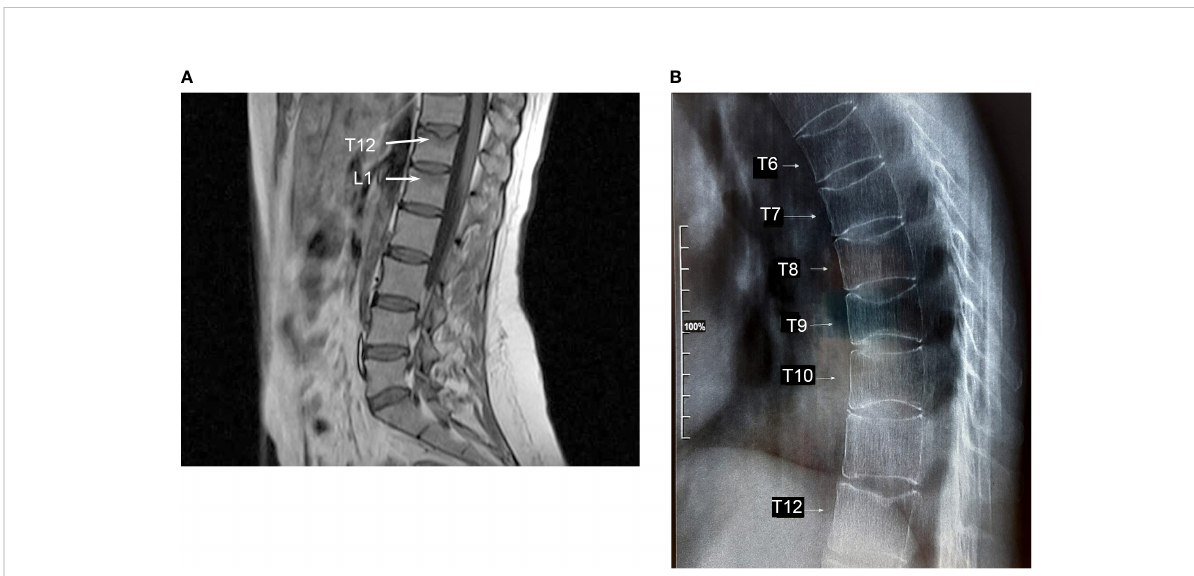
FIGURE 2 (A) Magnetic resonance imaging of the lumbar spine revealing the presence of vertebral fractures of T12 and L1. Peri-lesion edema of both vertebrae indicating recent fractures is shown (arrows). (B) X-ray of the thoracic spine shows vertebral fractures from T6 to